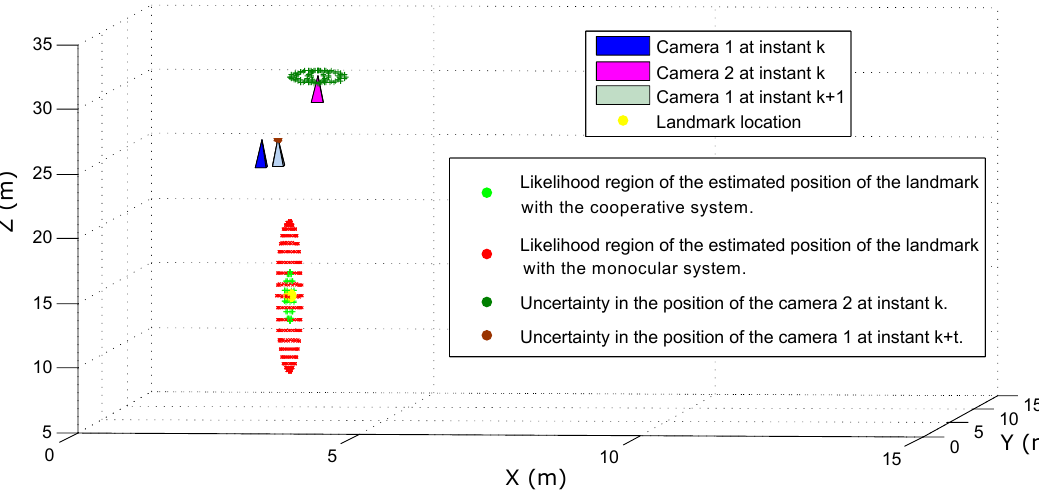
Figure 12. Measurement of a single landmark using: (i) cooperative pseudo-stereo system; and (ii) the delayed monocular initialization method.